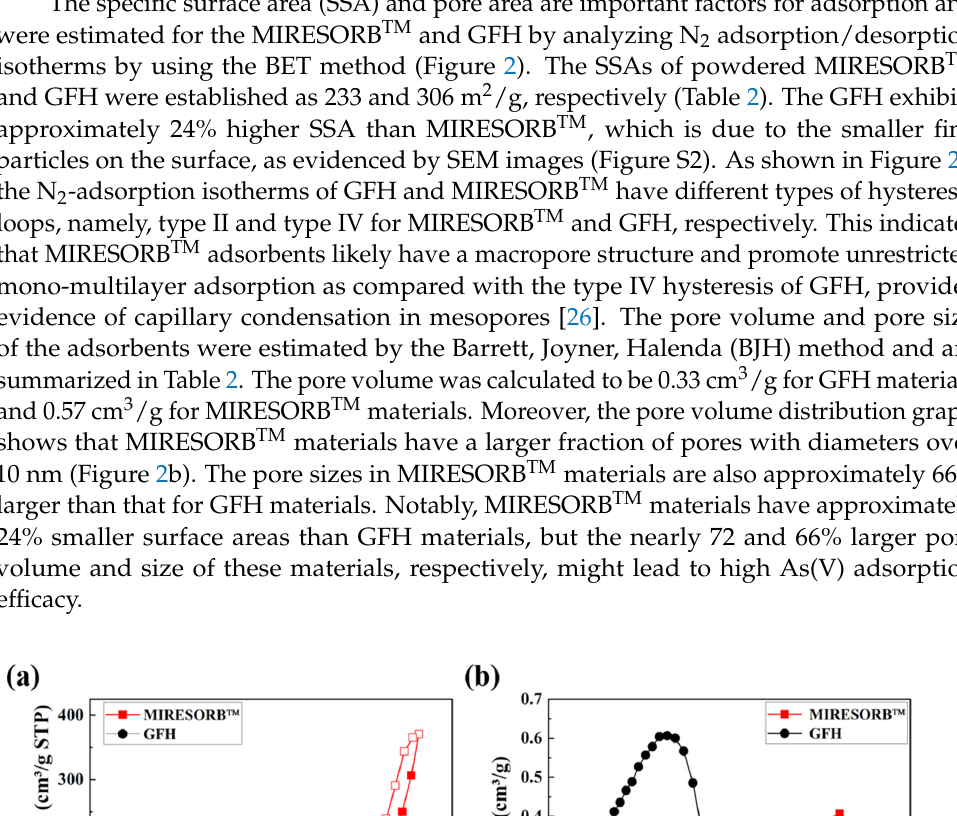
Table 1. Elemental compositions estimated by X-ray fluorescence spectrometry.